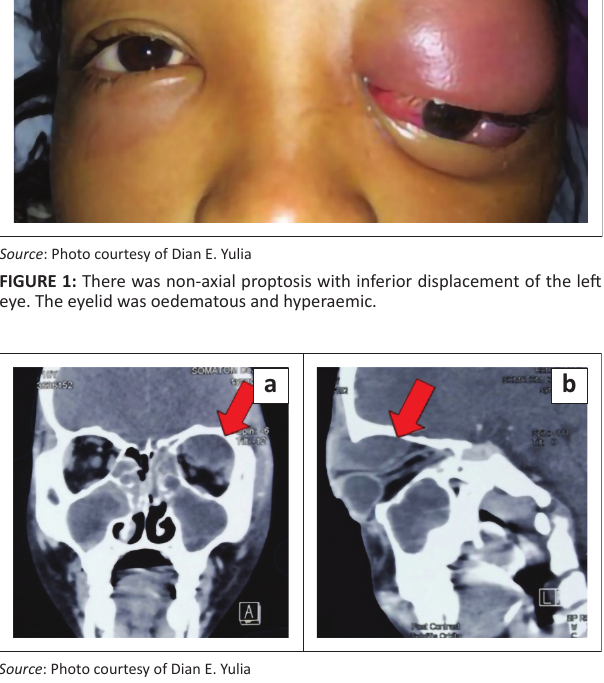
Source : Photo courtesy of Dian E. Yulia FIGURE 2: (a) Computed tomography scan showing a well-demarcated hypodense lesion in the superior extraconal left orbital cavity (arrow), suggesting a subperiosteal abscess formation; and (b) sagittal view of a computed tomography scan showing that the subperiosteal abscess extended posteriorly to the extraconal retrobulbar